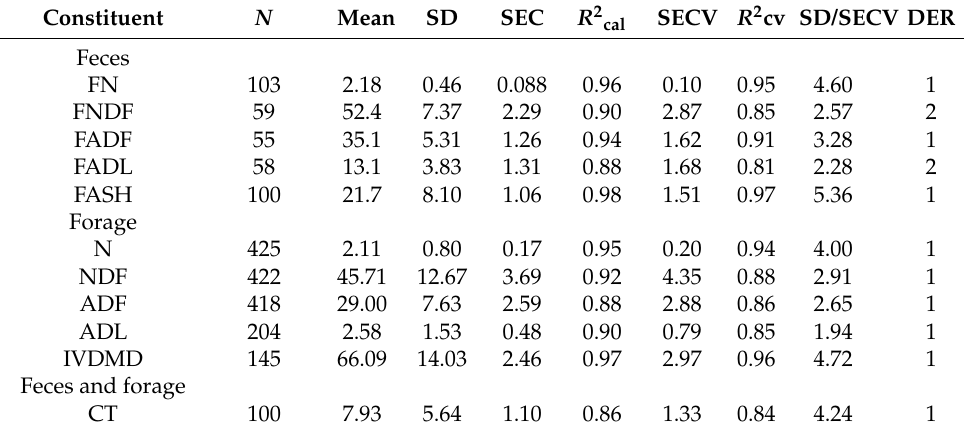
Table 1. Near-infrared spectrometry (NIRS) calibration performance for the prediction of the chemical composition of oryx feces and browse available on the range, including the number of samples used in calibrations ( N ), mathematical treatment (DER, 1st or 2nd derivative), standard error of calibration (SEC) and cross-validation (SECV), and the coefficients of determination of calibration ( R 2 cal) and cross-validation ( R 2 CV ).